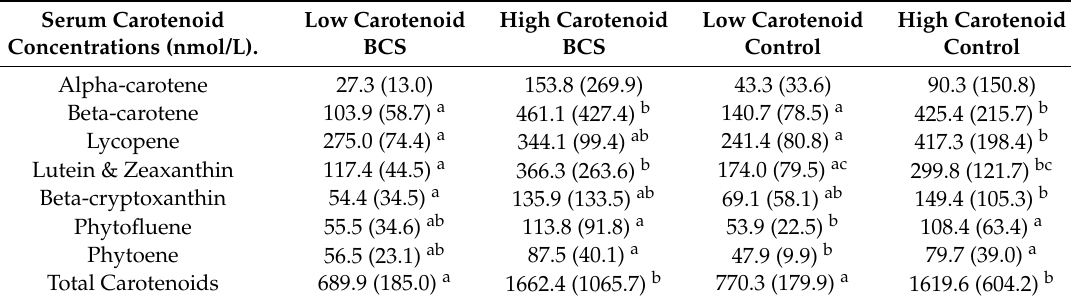
Table 4. Serum Carotenoid Concentrations.